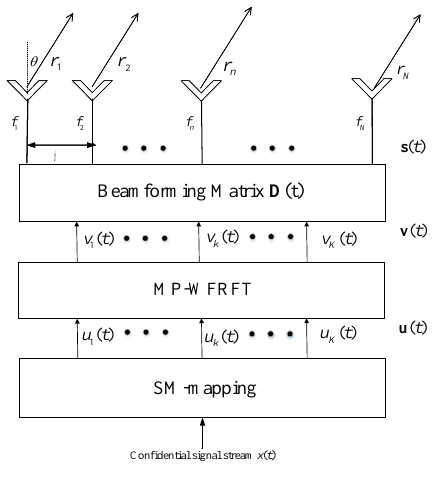
Figure 3. The architecture of the transmit